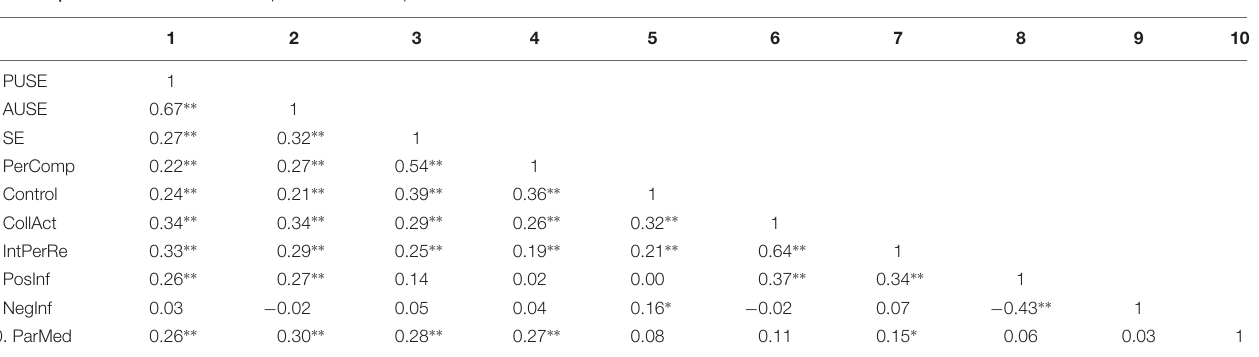
TABLE 3 | Correlation between the dependent and independent